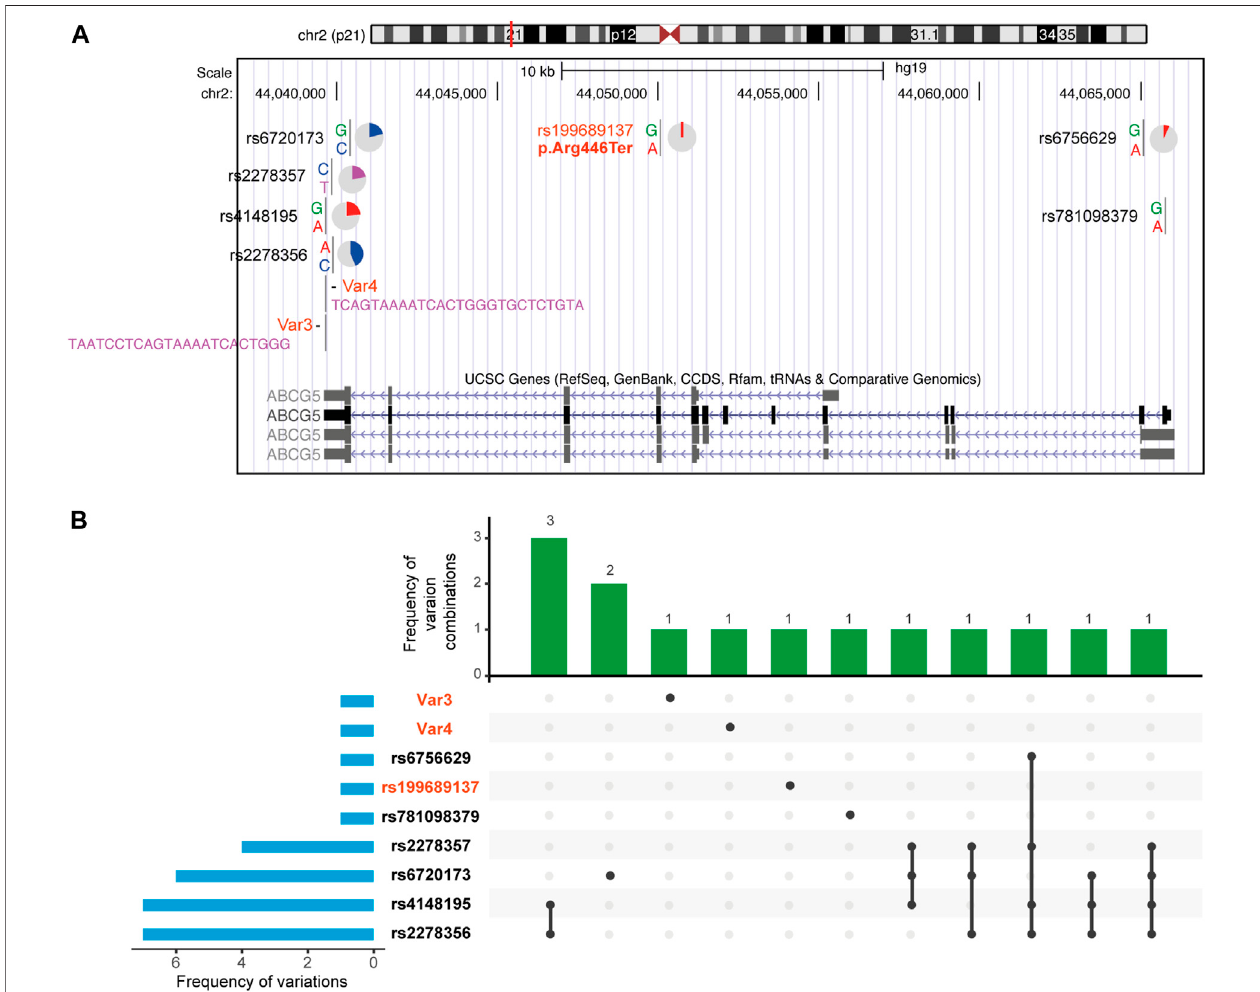
FIGURE 4 | Nine ABCG5 variants in 30 individuals with abnormal platelet size distribution. Details of each variation are in Supplementary Table S4 . Genetic variations of them are more commonly seen in the 3 ′ UTR of the gene model. Except for 3 pathogenic and likely pathogenic variations are heterozygotes in affected individuals, other variations are all